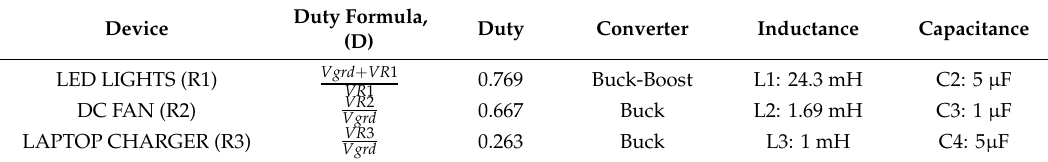
Figure 4. Proposed arrangement for 24–240 V Devices. Table 2. Calculated values of various converter parameters for energizing LV devices.